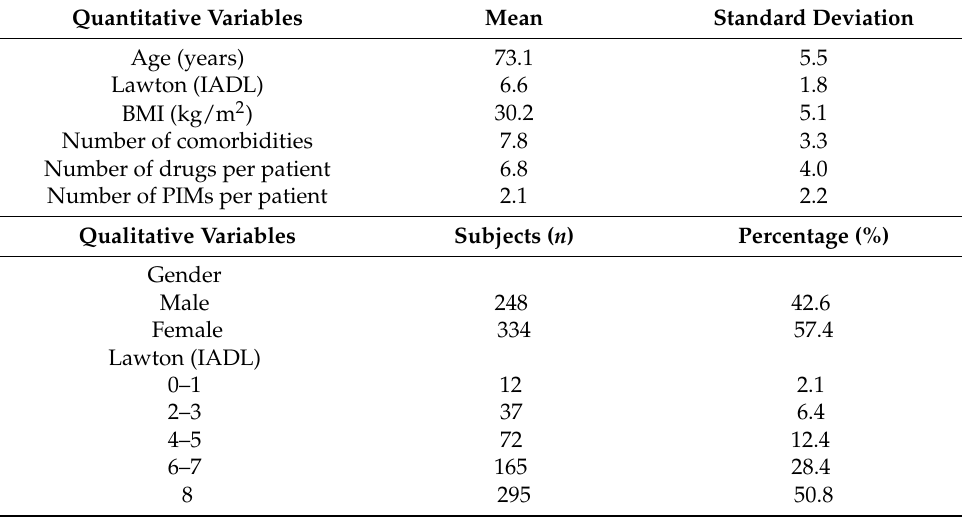
Table 1. Characteristics of the study population ( n =